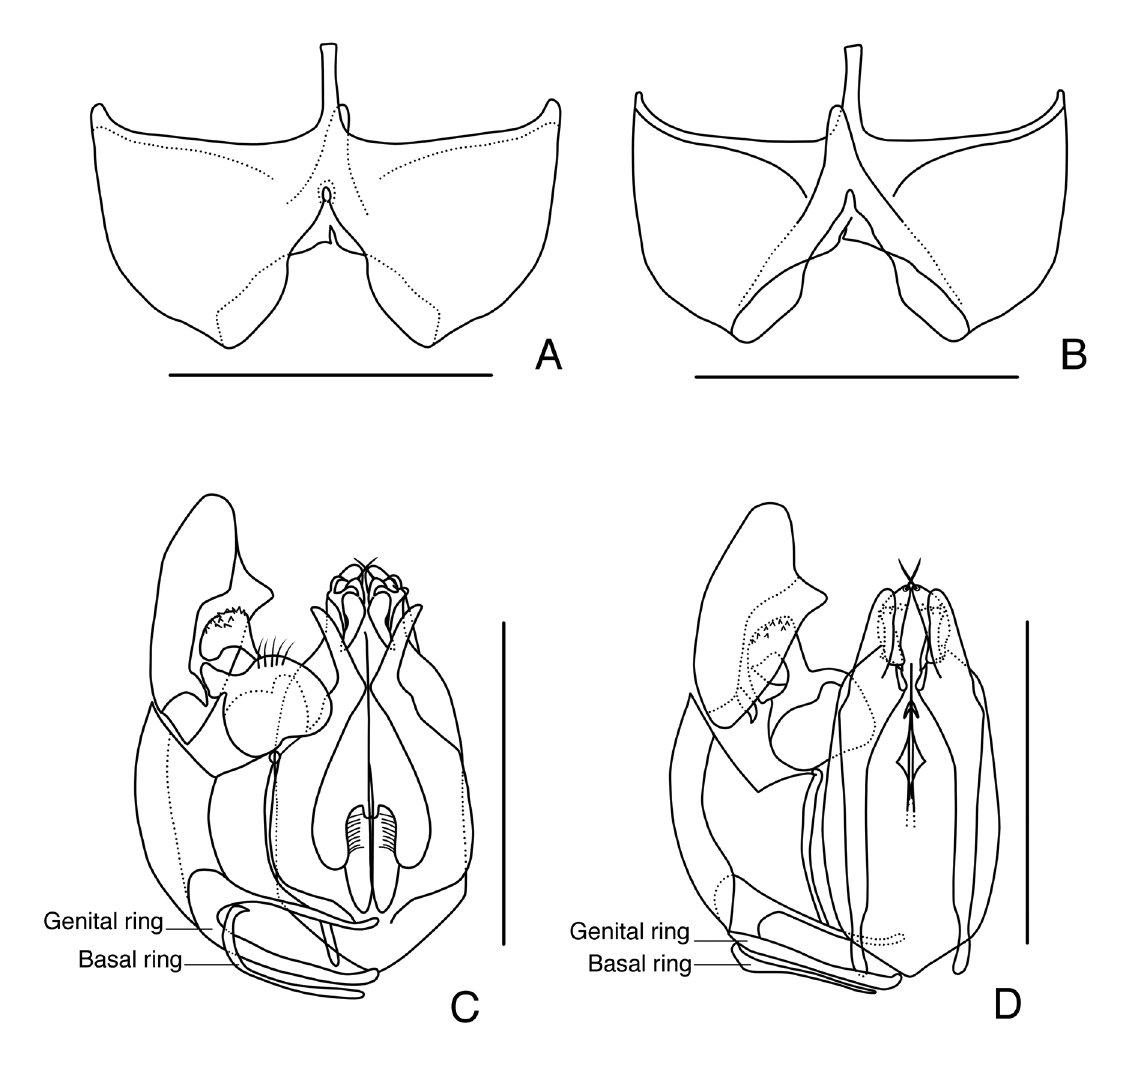
Fig. 6. Apenesia tagala comb. nov., holotype, ♂. A . Hypopygium, outer view. B . Hypopygium, inner view. C . Genitalia, ventral view. D . Genitalia, dorsal view (bars 0.5